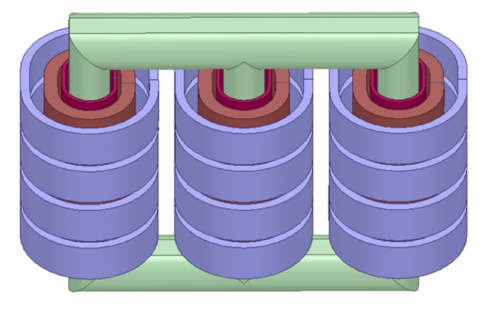
Figure 4. 3D model of an inductive filter